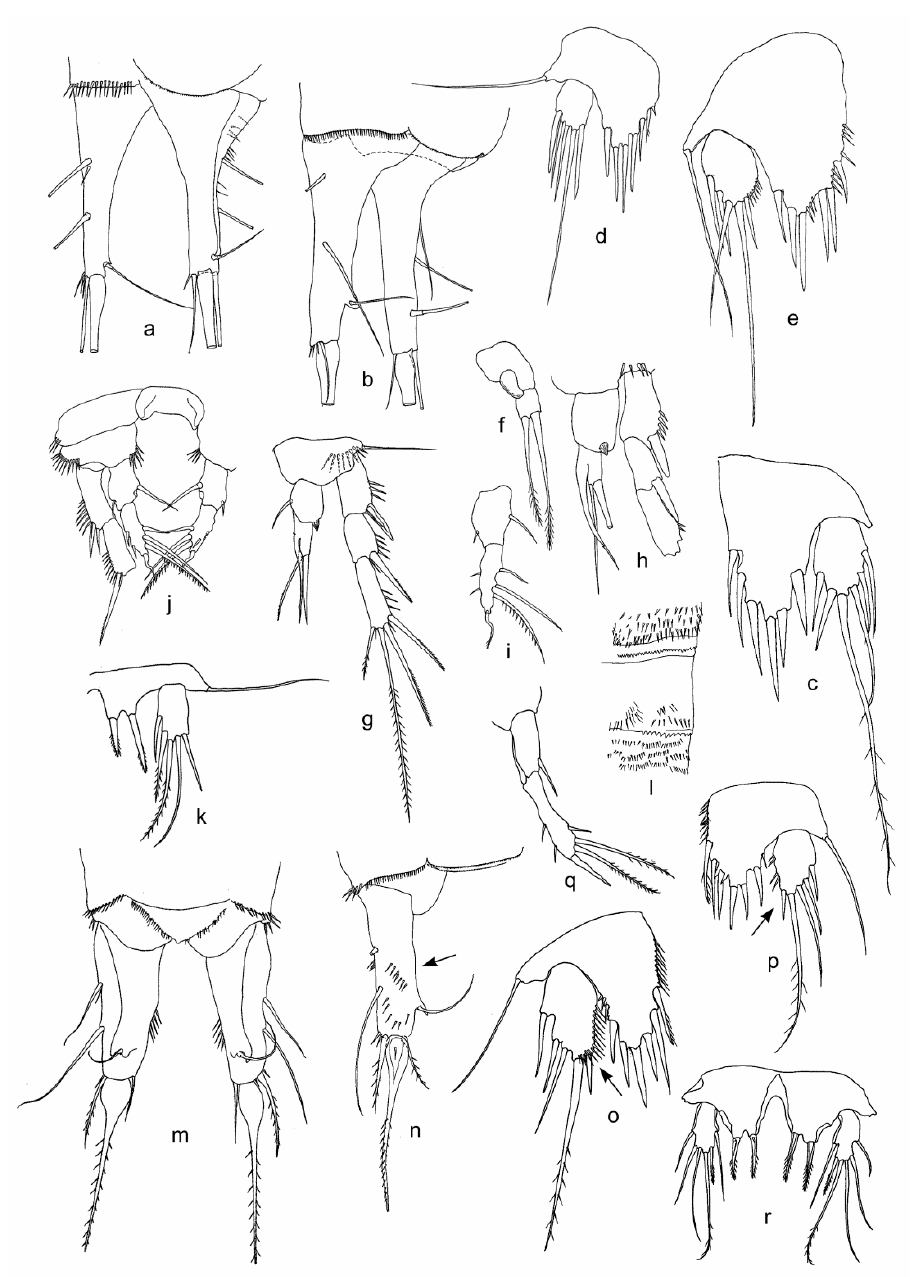
Figure 5. Features of females ( b , d , e ,) and males ( a , f–k ) of Moraria longicauda , female of M. sp. 1 ( c ), and females ( l , m–p ) and male ( q , r ) of M. spinulosa from Lake Baikal sites: SPb ( a , c , h , g , i , k ), Bkl ( b , d , f , h , j ), BGl-l ( e , l ), and OsR ( m – r ). ( a , b , n ) — caudal rami, lateral view; ( c , d , e , k , o – r )—P5; ( f )—P2 endopod; ( g , h )—P3; ( i , j , q )—P4 endopods; ( l )—arming of integument of a body somite; and ( m )—furca, dorsal view. Abbreviations in Tables 1 and 2. Some features are shown by arrows. Material : 1 ♀ and 1 ♂ from Mud Volcano Malenky (No. 15) and 2 ♀♀ from the site near the River Bolshaya Osinovka mouth.